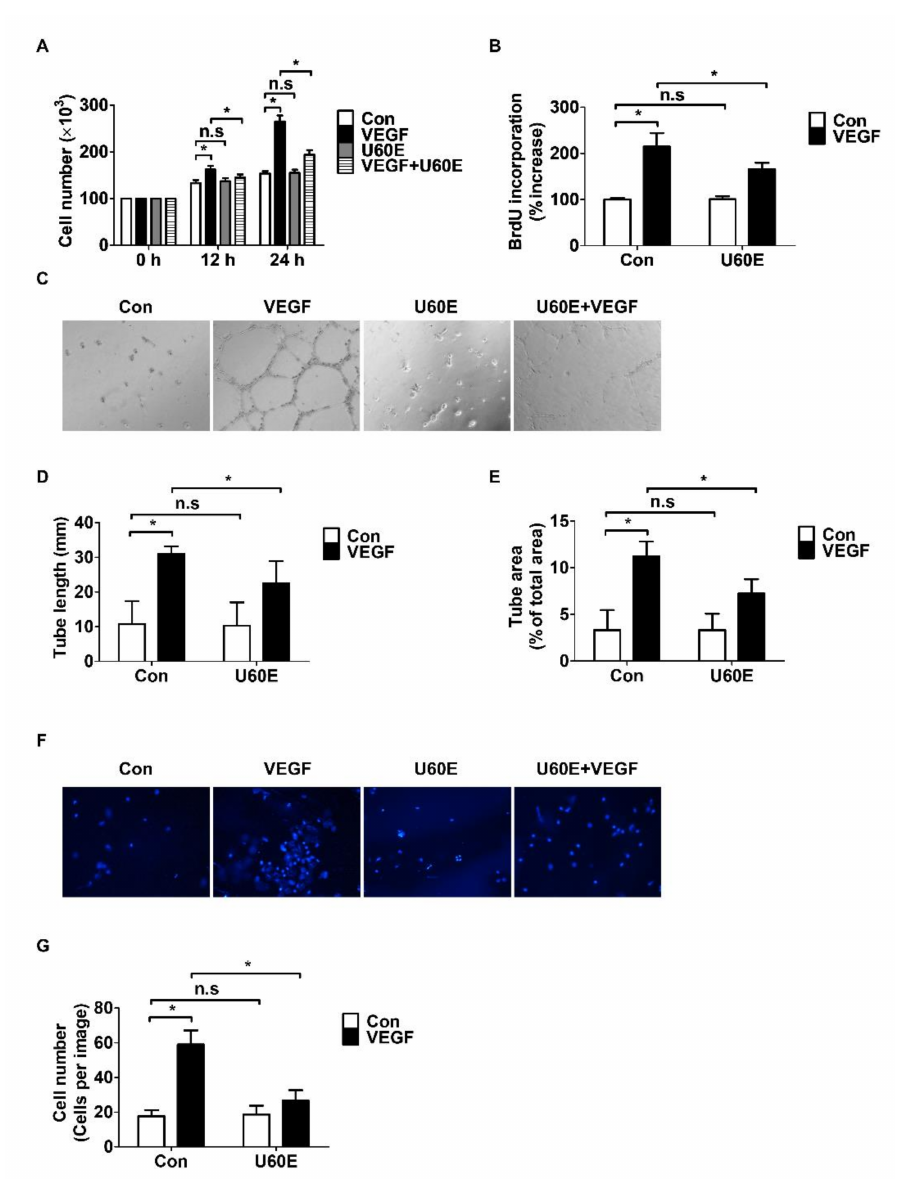
Figure 2. Effect of U60E on VEGF-induced angiogenesis of HUVECs. ( A ) Proliferation of HUVECs treated with VEGF (20 ng/mL) and/or U60E (20 µ g/mL) for indicated times was determined by cell counting. The graph represents the means ± SD ( n = 3). ( B ) HUVECs were treated with VEGF (20 ng/mL) and/or U60E (20 µ g/mL) for 24 h. Cell proliferation was determined by a BrdU proliferation ELISA kit. Results are expressed as percentage increase in BrdU incorporation versus control value. Means ± SD ( n = 4). ( C ) Representative images of tube formation by HUVECs treated with VEGF (20 ng/mL) and/or U60E (20 µ g/mL) for 24 h. Original magnification × 40. ( D , E ) Quantitative analysis of tube lengths (mm) and tube area (% of total area) in ( C ) was performed. The bar graph represents the means ± SD ( n = 4). ( F ) Representative images of cell migration of HUVECs treated with VEGF (20 ng/mL) and/or U60E (20 µ g/mL) for 24 h. The migrated cells were stained with DAPI solution. Original magnification × 40. ( G ) Quantitative analysis of cell migration in (F) was performed. The bar graph represents the means ± SD ( n = 4). n.s indicates p > 0.05, * p <